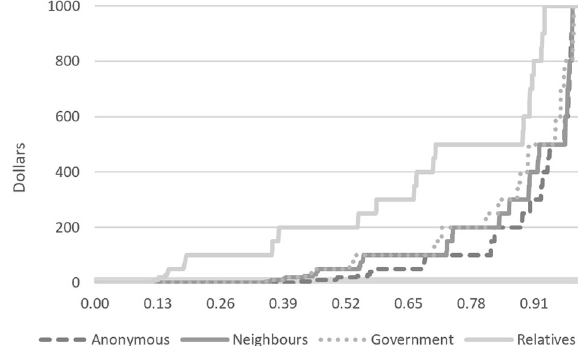
Fig. 2 Probability densities of donations by receiver. Distributions of the probability of donations falling within 0 and US$1000, for each of the four dictator game types.